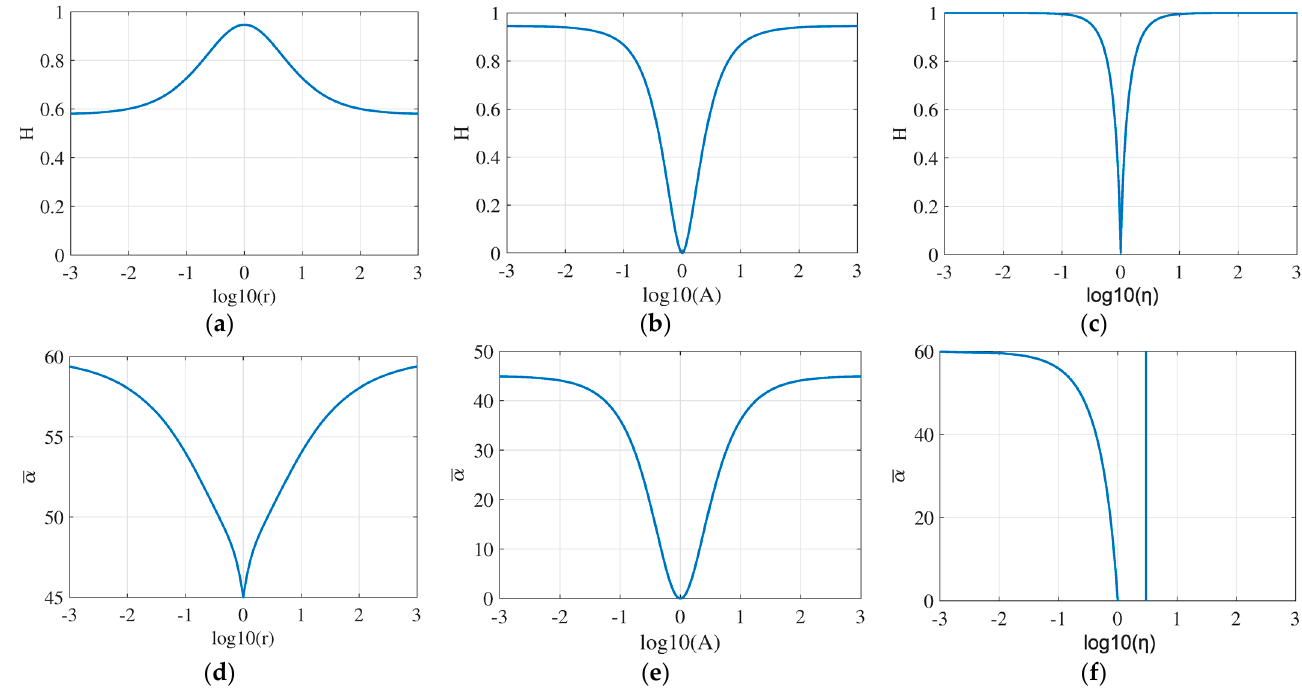
Figure 3. H and 𝛼(cid:3364) of the volume scattering model. ( a ) H of GVSM; ( b ) H of RPCM; ( c ) H of FRE2 volume model; ( d ) 𝛼(cid:3364) of GVSM; ( e ) 𝛼(cid:3364) of RPCM; ( f ) 𝛼(cid:3364) of FRE2 volume model. volume model; ( d ) α of GVSM; ( e ) α of RPCM; ( f ) α of FRE2 volume